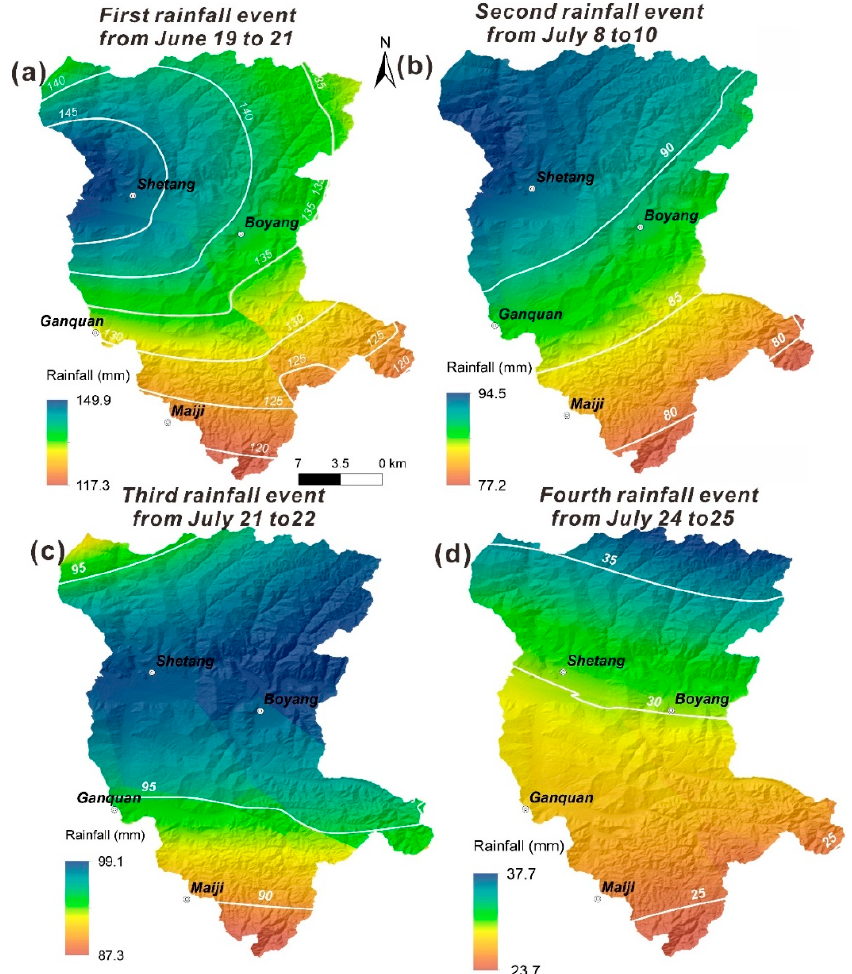
Figure 6. Spatial distribution of the rainfall with four events from June to July in the study area: ( a ) First rainfall event, from June 19 to 21. ( b ) Second rainfall event, from July 8 to 10. ( c ) Third rainfall event, from July 21 to 22. ( d ) Fourth rainfall event, from July 24 to 25.